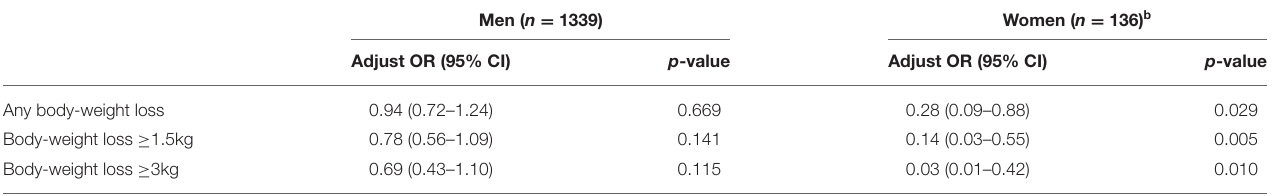
TABLE 3 | Multivariable logistic regression for predictors of failed 6-month smoking abstinence after replacing covariable of body weight gain by body weight loss a